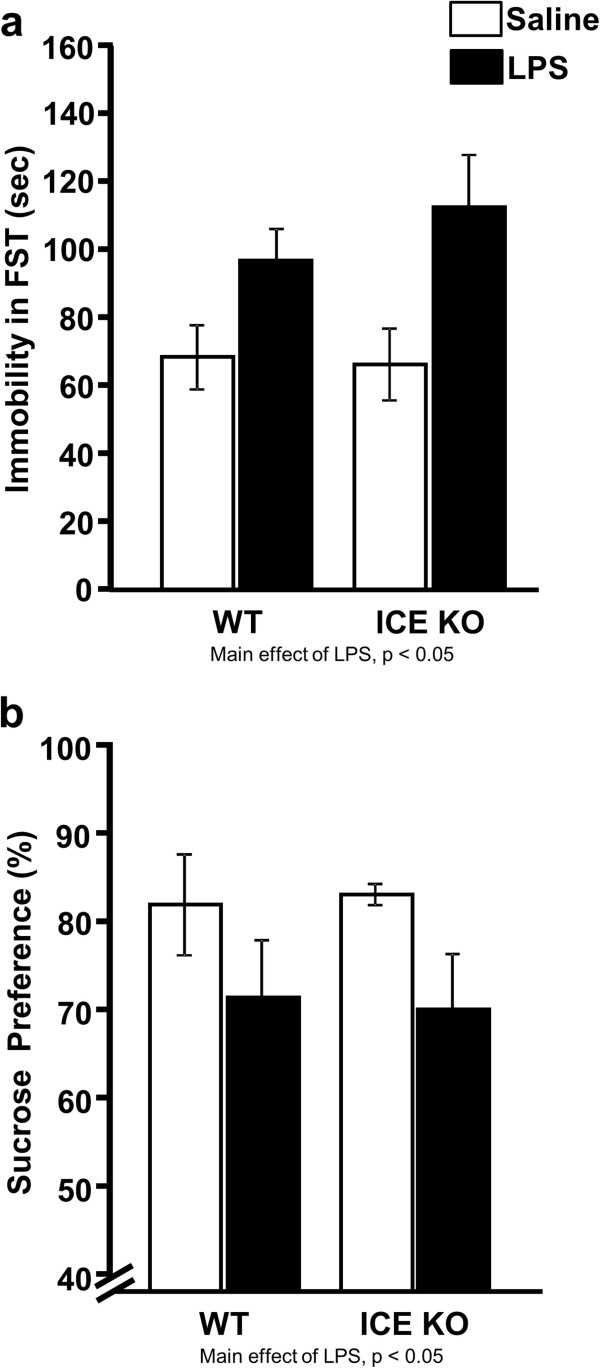
Both ICE KO and WT mice displayed depression-like behaviors following IP LPS challenge. LPS given systemically increased (a) immobility in the FST 24 h after treatment and decreased (b) sucrose preference when measured 24 to 48 h post-treatment similarly in both mouse strains. Data represent averages ± SEM; main effects of LPS where indicated; n = 6 mice per group.